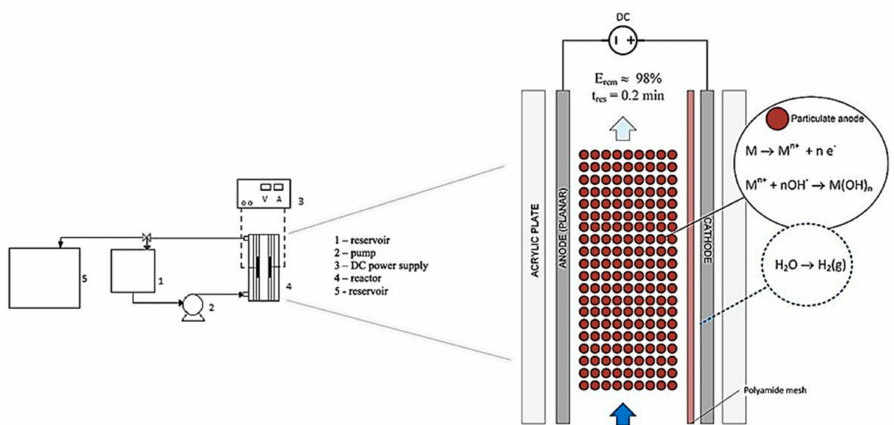
Figure 19. Schematic representation of the experimental system (adapted from Rodrigues et al. [18]).